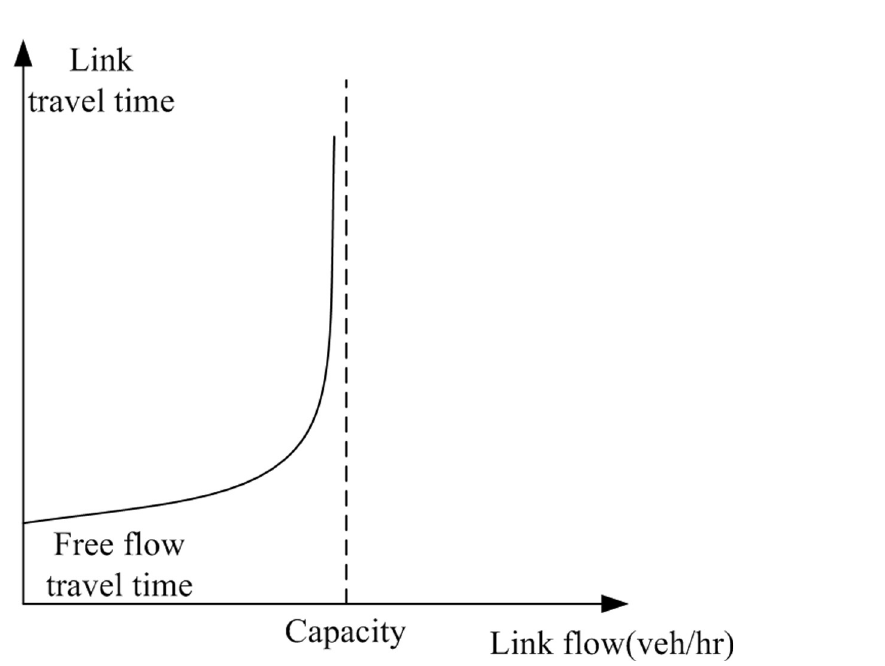
Fig 5. Typical link performance function (Source: Fig 1.8